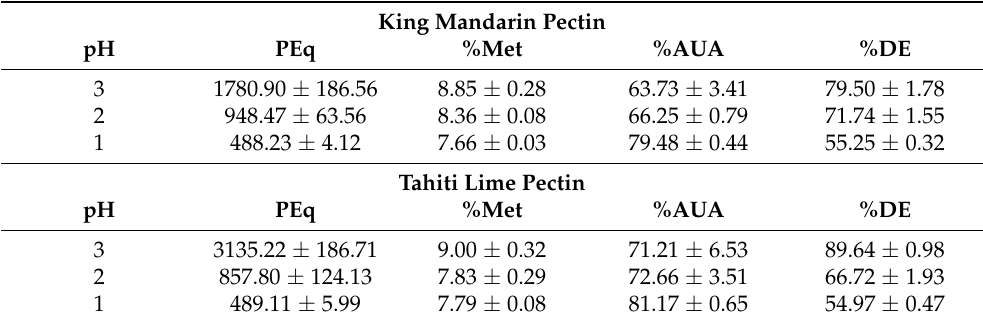
Table 1. Physicochemical characterization of King mandarin and Tahiti lime